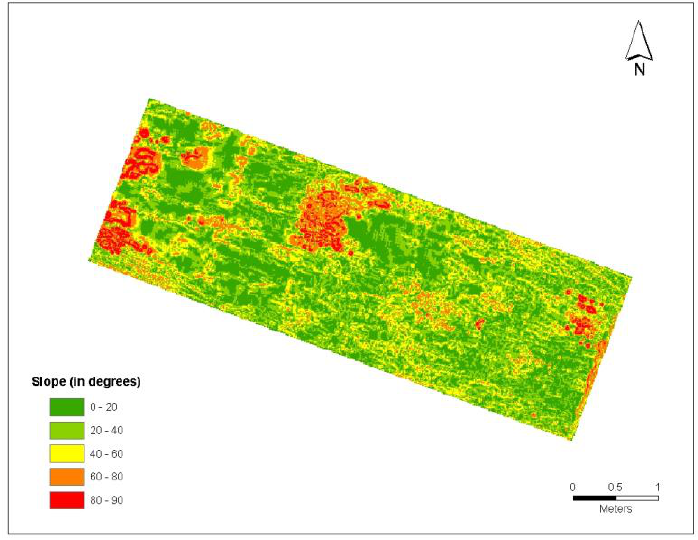
Figure 5. Slope map of the plot. Slope values were derived from 1 cm DSM of plot. Reddish areas have slopes greater than 60°.